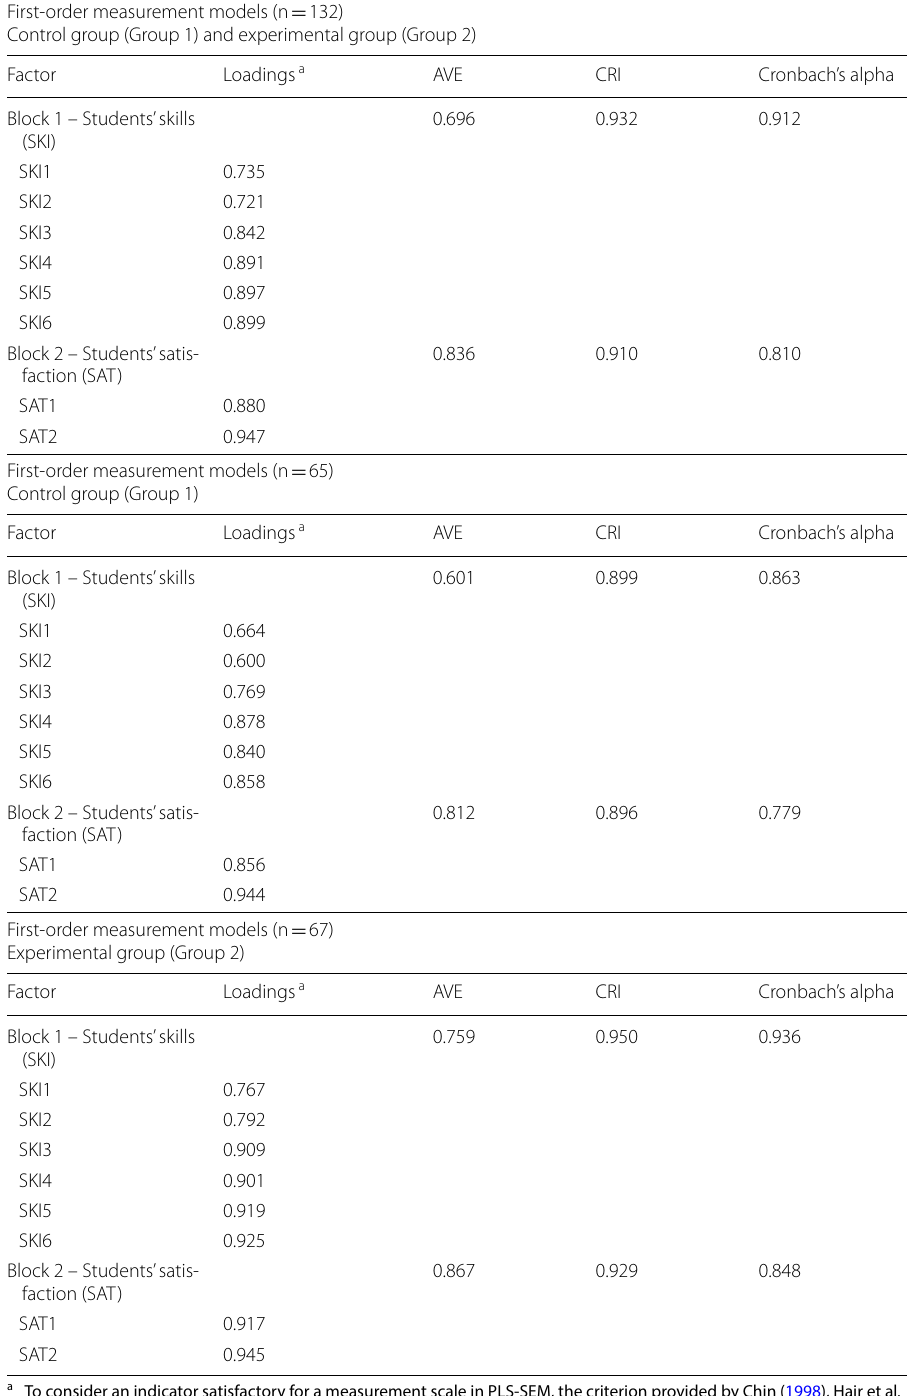
Table 3 First‑order measurement